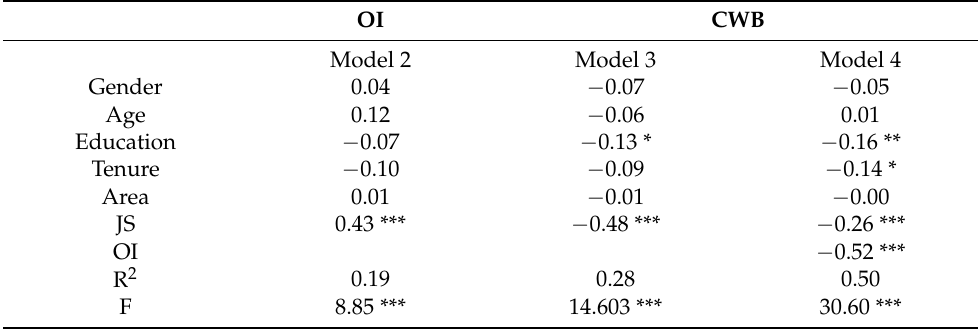
Table 3. Regression result for job security, organizational identification, and CWB.